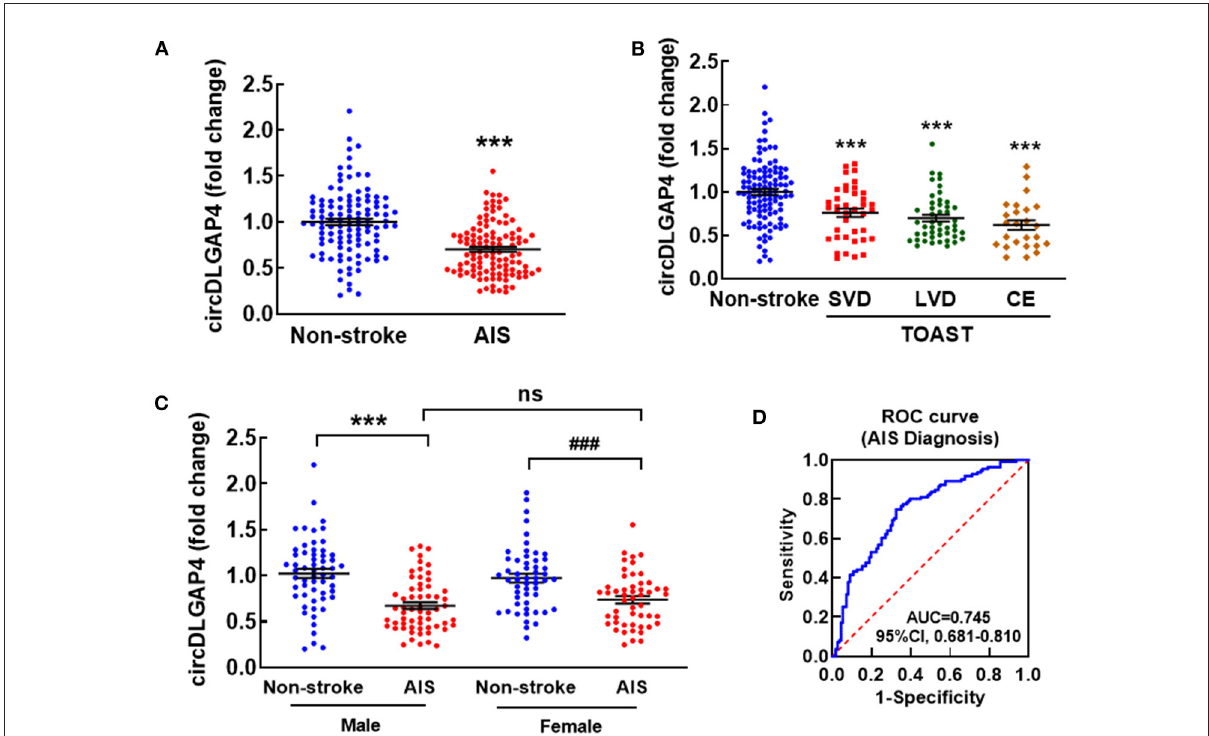
FIGURE1 Downregulation of circDLGAP4 in patients with AIS. (A) circDLGAP4 expression levels in the plasma of patients with AIS increased compared with that in non-stroke controls. N = 111 individuals/group. ( *** p < 0.001, AIS vs. control using the Mann–Whitney test). (B) Relative plasma circDLGAP4 levels in patients with stroke categorized by TOAST criteria and non-stroke controls. The SVD group, n = 39; the LVD group, n = 47; the CE group, n = 25. *** p <0.001 vs. non-stroke controls (1-way ANOVA followed by the Holm-Sidak post-hoc multiple comparisons test). (C) circDLGAP4 expression levels in the plasma of male and female patients with AIS decreased compared with that in male and female non-stroke controls. ( *** p < 0.001, male AIS vs. male control, ### p < 0.001, female AIS vs. female control using the Mann–Whitney Test). (D) ROC curves for circDLGAP4 to separate patients with AIS from non-stroke controls. AUC, area under curve; CE, cardio embolism; LVD, large vessel disease; ROC, receiver operating characteristic curve; SVD, small vessel disease; and TOAST, Trial of Org 10172 in Acute Stroke